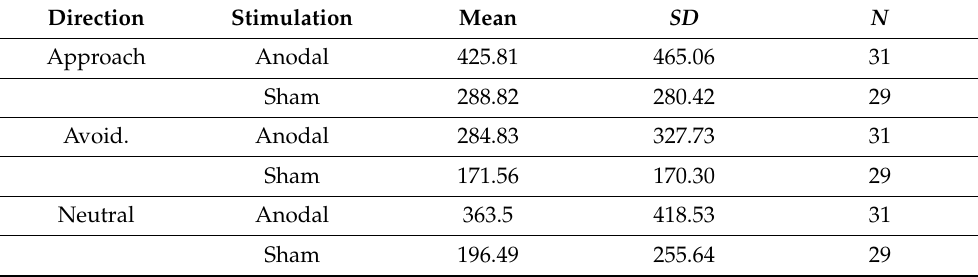
Table 3. Descriptive statistics of reading improvement as a function of the type of sentence and the tDCS